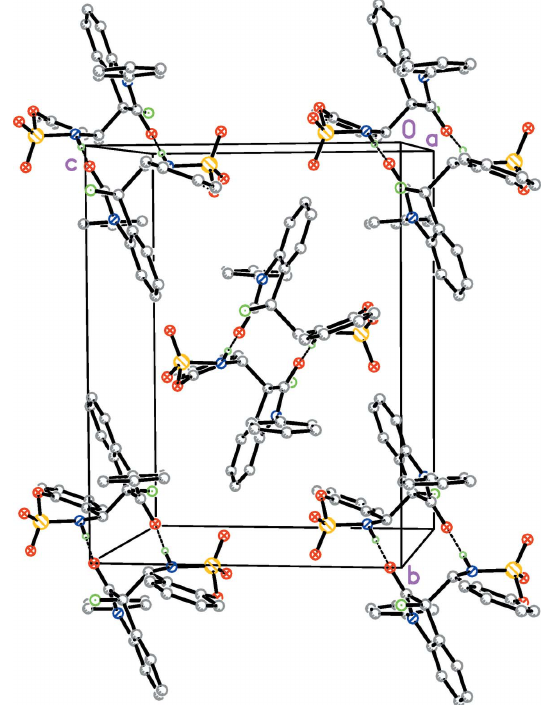
Figure 2 Aview of the packing diagram showing the centrosymmetric dimers with N—H (cid:2)(cid:2)(cid:2) O hydrogen bonds as dashed lines.